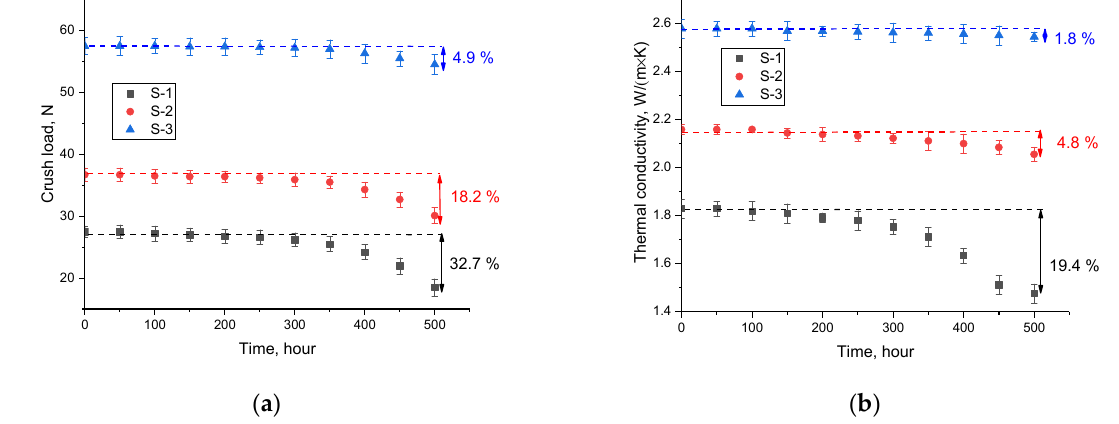
Figure 7. ( a ) Results of the stability of crack resistance during long-term thermal heating; ( b ) the results of the change in the thermal conductivity coefficient depending on the time of thermal tests.